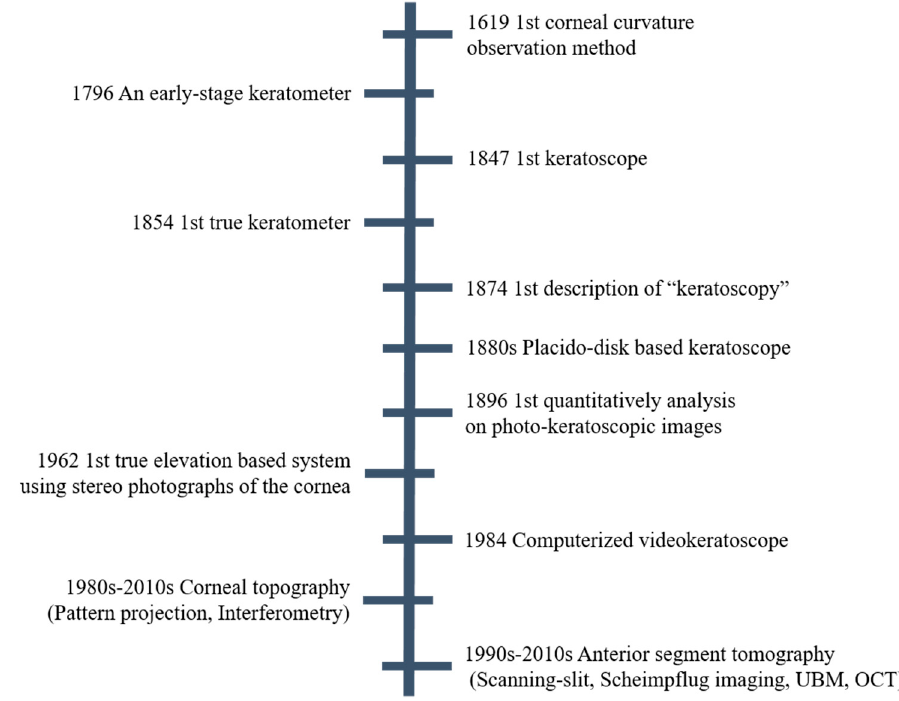
Figure 2. Development of the anterior segment measurement technologies.